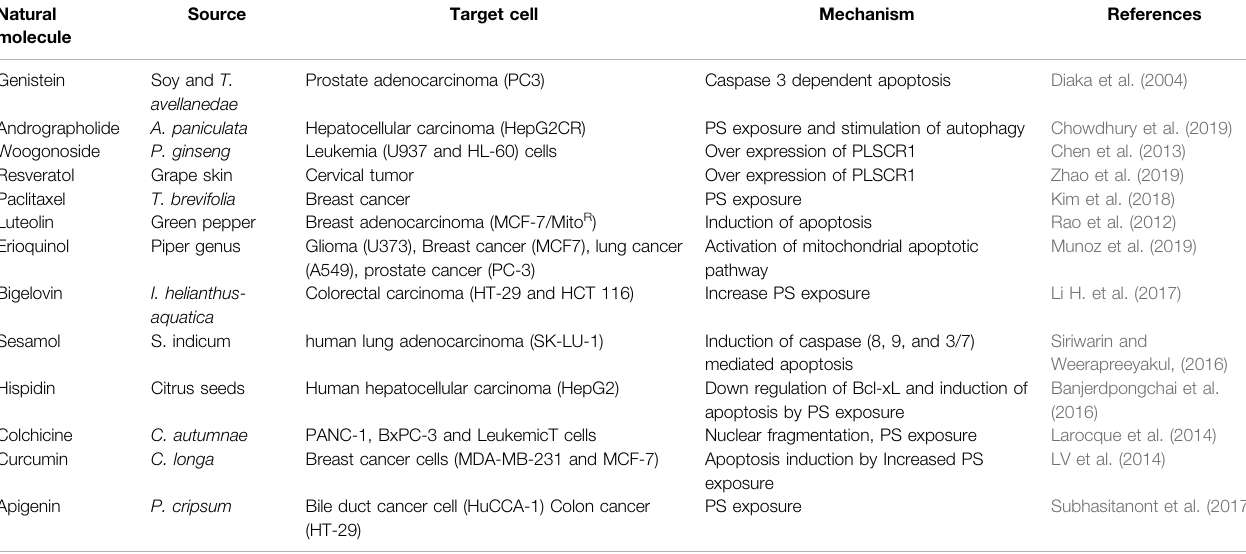
TABLE 2 | Phytochemicals that induce apoptosis in cancer cells through PS